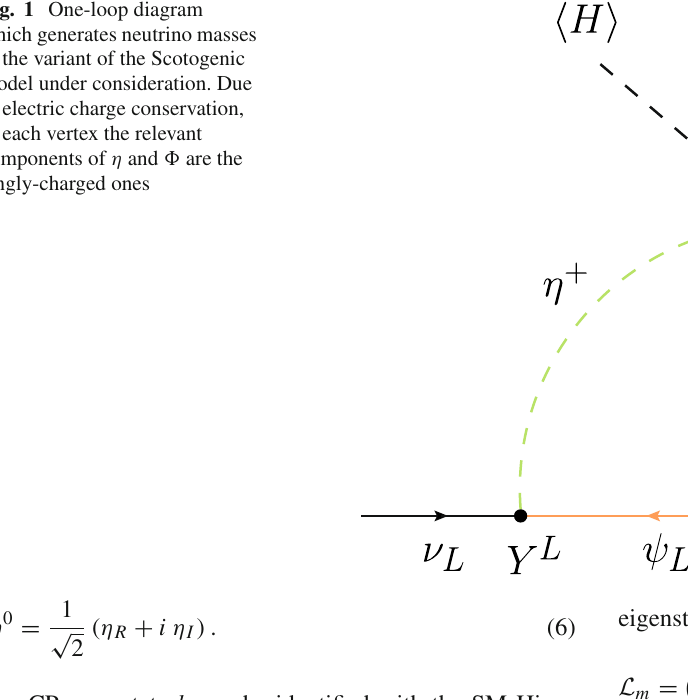
Fig. 1 One-loop diagram which generates neutrino masses in the variant of the Scotogenic model under consideration. Due to electric charge conservation, in each vertex the relevant components of η and (cid:3) are the singly-charged